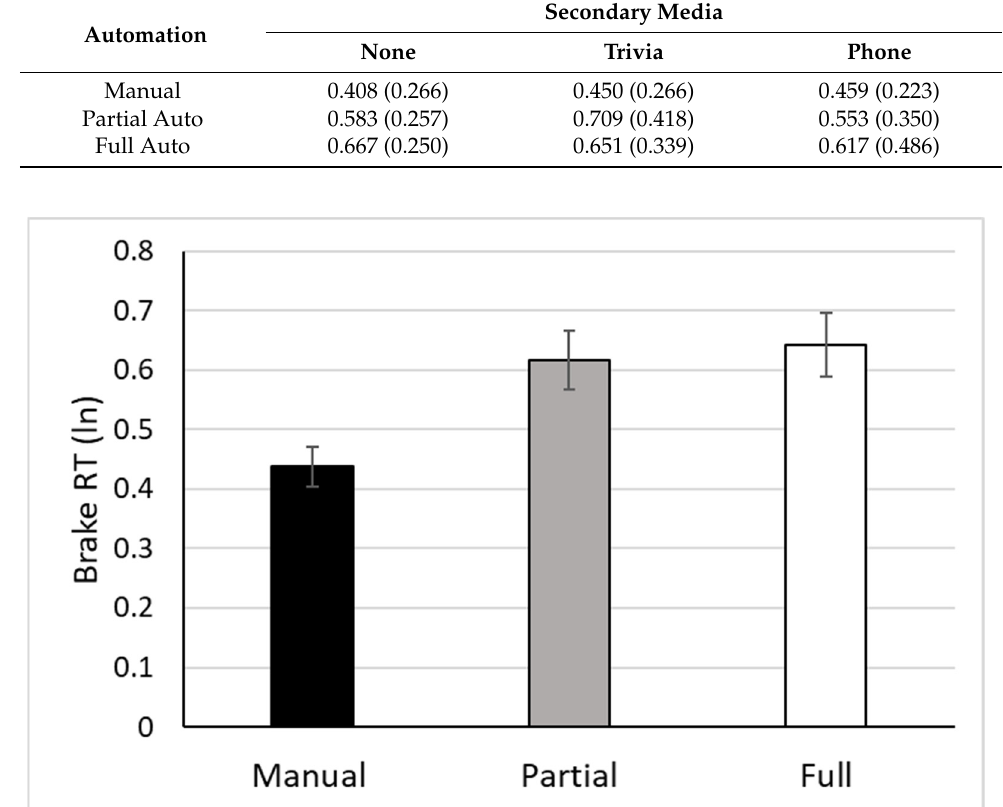
Table 5. Log RTs (and SDs) for braking response as a function of secondary media and automation conditions.